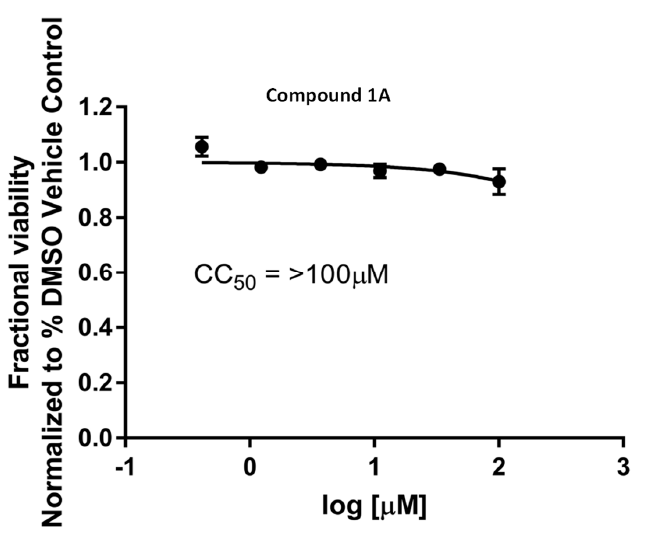
Figure 6. Cytotoxicity measurement.